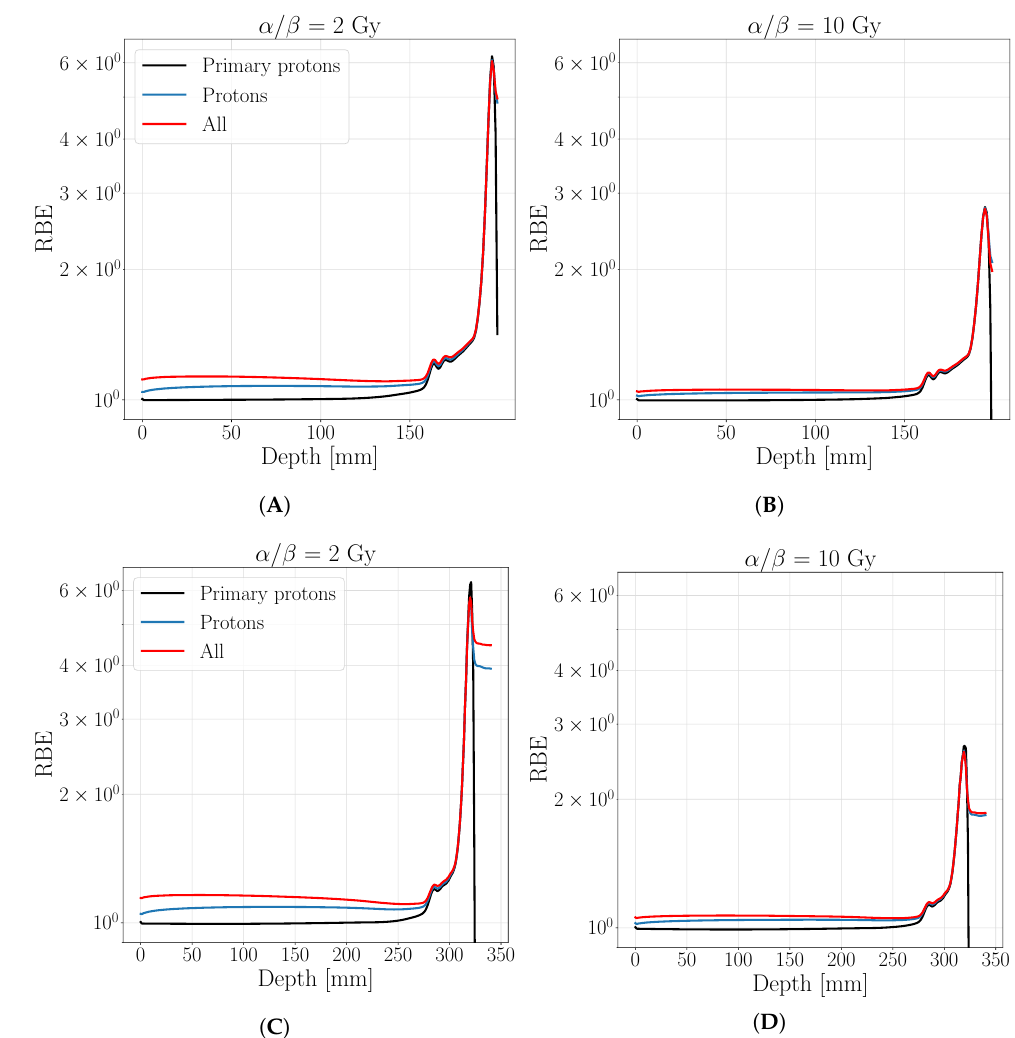
Figure 6. Relative biological effectiveness for a SOBP calculated with a biological optimization on a target 30 30 30 mm at a depth of 160 mm ( A , B ) and 280 mm ( C , D ) for a tissue of α / β = 2 Gy × × ( A , C ) and α / β = 10 Gy ( B , D ). The black line represents the RBE obtained by considering only primary protons, the blue one is obtained including all protons while in red all protons and target fragment contribution. The legend stands for both